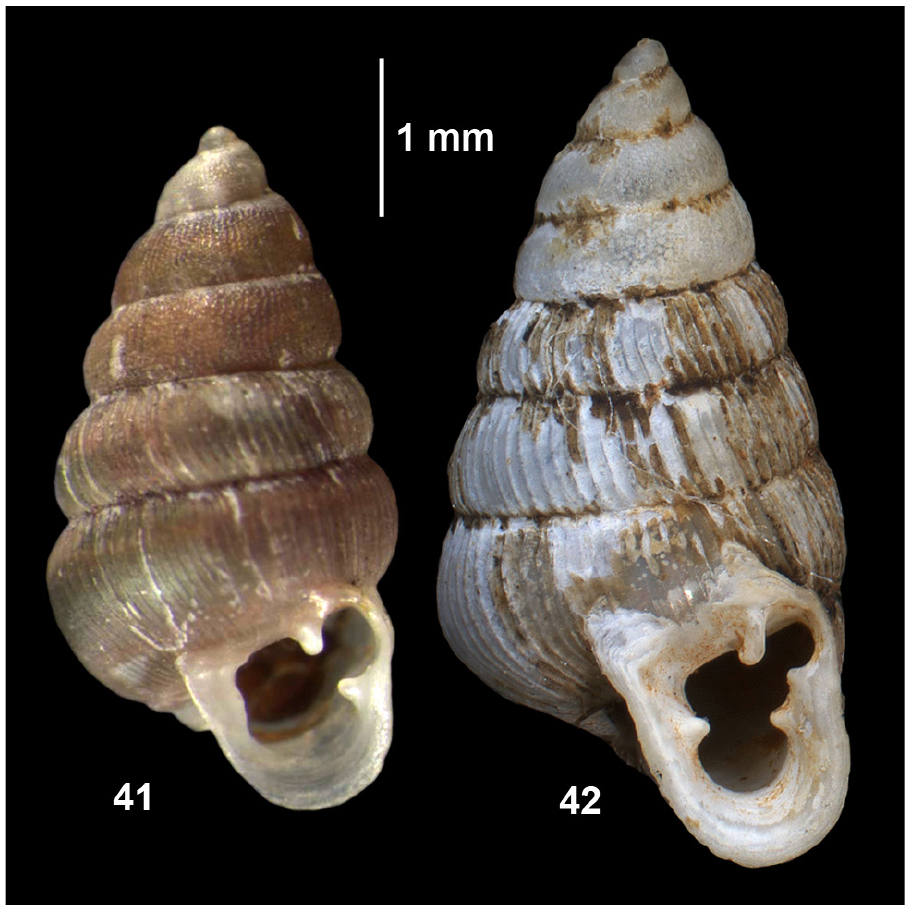
Figs 41-42. Adult shells of Dadagulella gen. nov. species. 41. D. rondoensis (Verdcourt, 1994) comb. nov., holotype, Rondo (photo by R. Janssen). 42. D. conoidea comb. nov., holotype, Kwamgumi (after Verdcourt